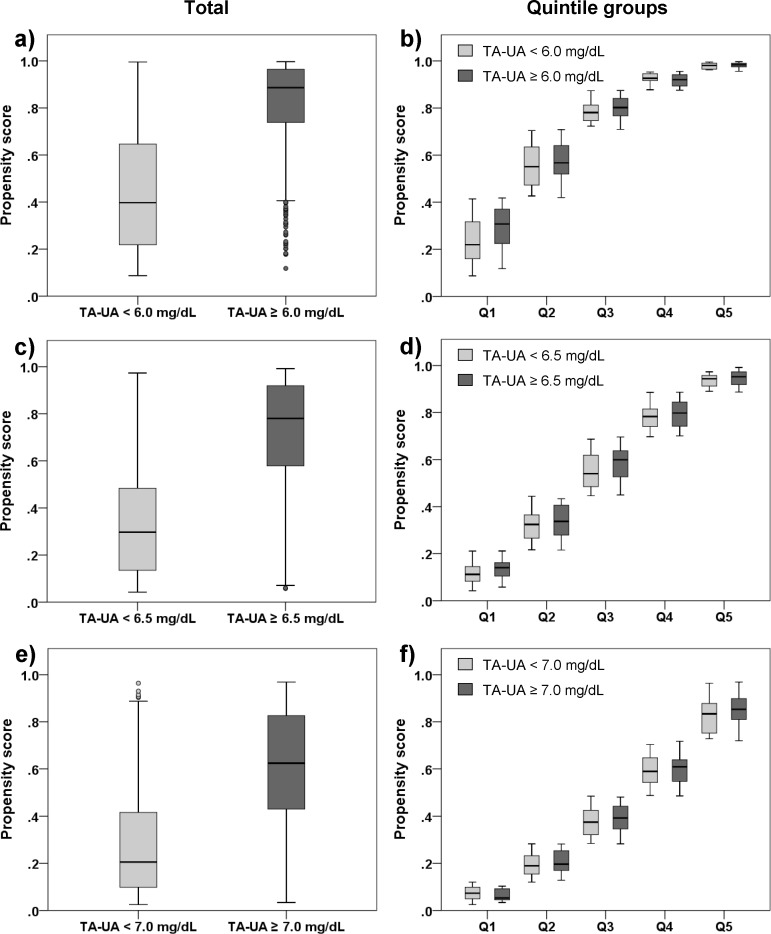
Box plot of the propensity scores stratifying on the quintiles of the propensity score.After trimming less than 2.5 percentile and greater than 97.5 percentile of the estimated propensity scores from the original cohort, a subsample was re-stratified on the quintiles of the propensity scores. In every substratum, the propensity scores are depicted by box-plots which represent the interquartile range and whiskers up to top most and the bottom most case within the 1.5 times the box length. Outliers appear as little circles. Estimated propensity scores between two groups separated by the threshold of time-averaged uric acid are well overlapped.